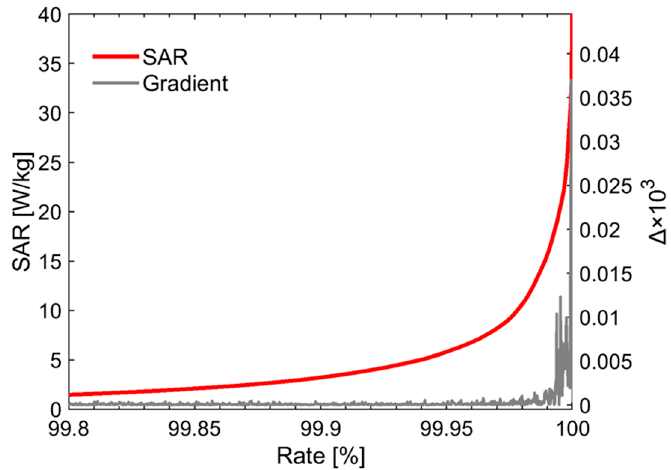
Figure A1. Computed results of SAR and its gradient for voxels of which the SAR has the highest value of 0.2% in the TARO head model.